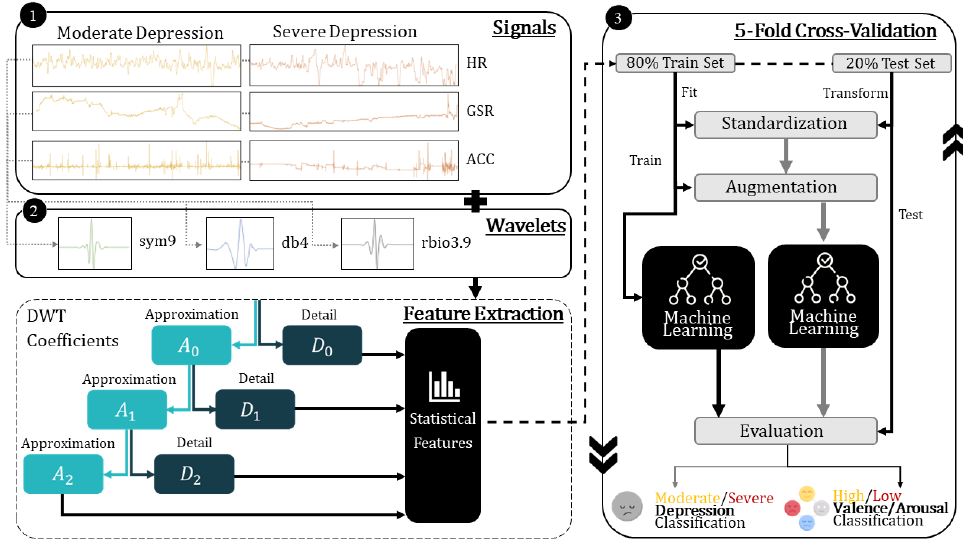
Figure 2. End-to-end model